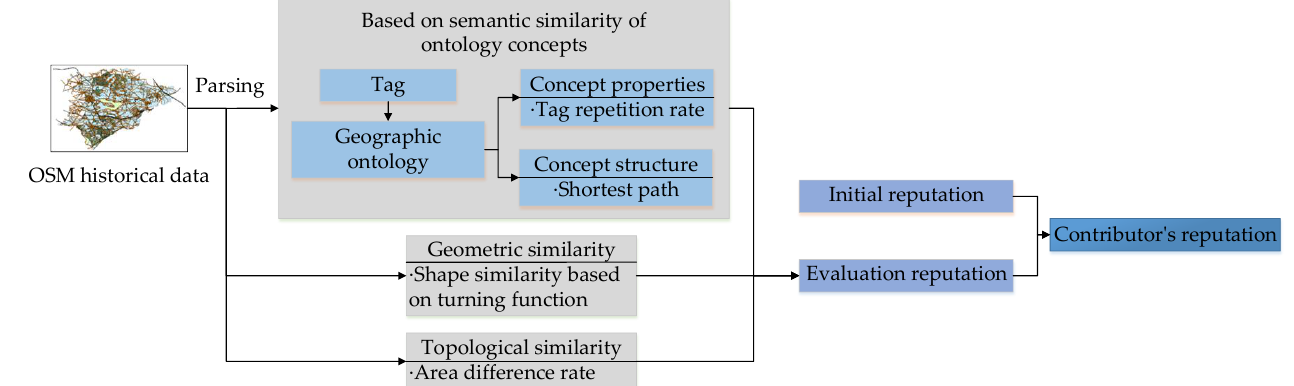
Figure 1. Flow chart of contributor’s reputation evaluation.